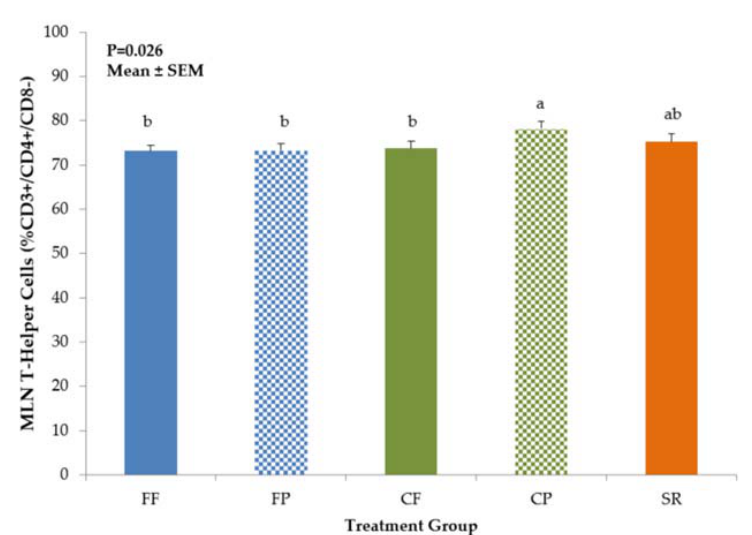
Figure 4. T-helper cells in MLN of 21-day-old piglets fed different diets. CP piglets had significantly higher populations of T-helper (CD3 + /CD4 + /CD8 − ) cells in their MLN compared to FF, FP, and CF groups, but was not different from SR. Values are mean ± SEM. Bars with different superscripts (e.g., a vs. b) indicate statistical significance at p < 0.05. Abbreviations: FF, formula-fed ( n = 12); FP, formula+prebiotic ( n = 10); CF, combination-fed ( n = 8); CP combination-fed+prebiotic ( n = 8); SR, sow-reared ( n = 7).